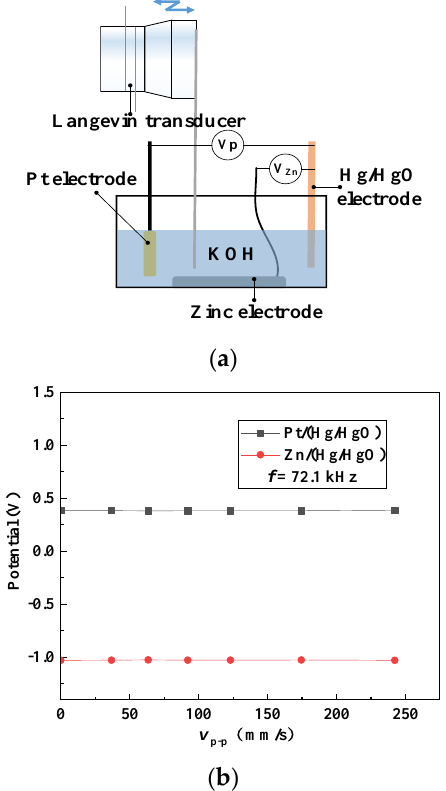
Figure 6. Independency of single-electrode potentials of the zinc – air battery on the electrolyte’s ultrasonic vibration. ( a ) Schematic diagram of testing device; ( b ) Measured Pt/(Hg/HgO) and zinc/(Hg/HgO) potentials.